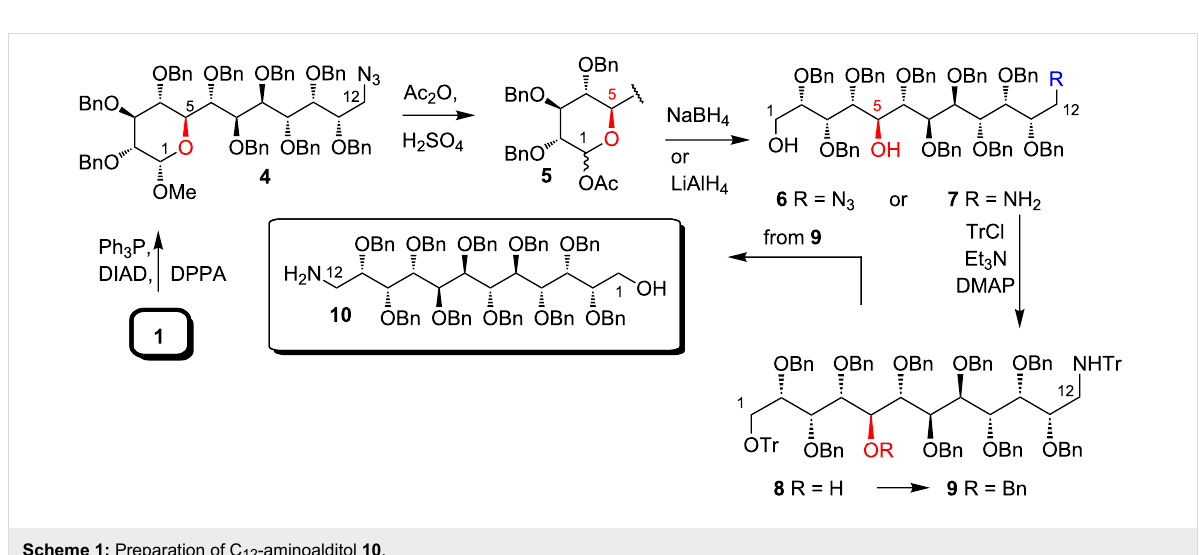
Scheme 1: Preparation of C 12 -aminoalditol 10